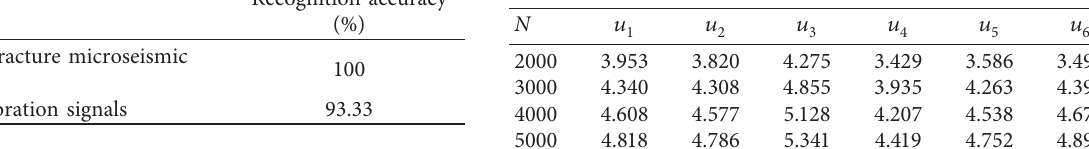
Table 5: Singular spectrum entropy of each of the modes of the four signals.